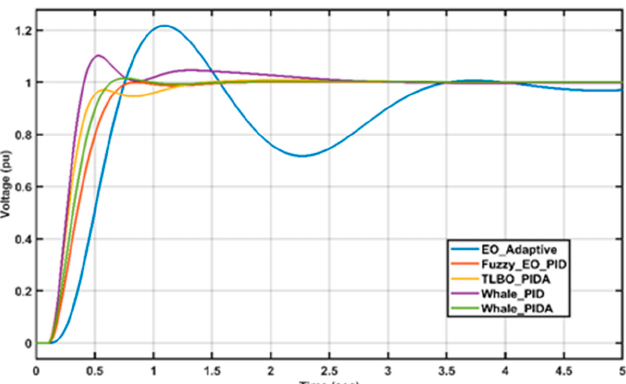
Figure 8. 1 pu step voltage reference for simple AVR model.